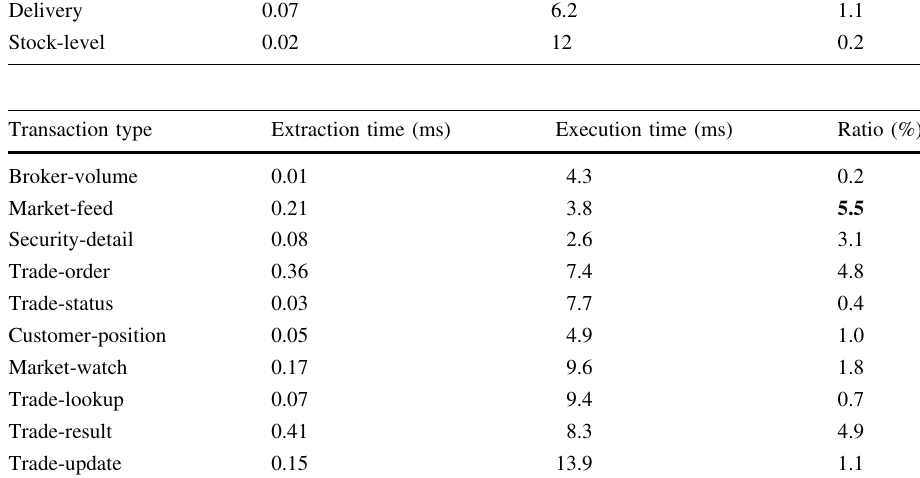
Table 1 Execution time (ms) spent on reordering block extraction on TPC-C benchmark